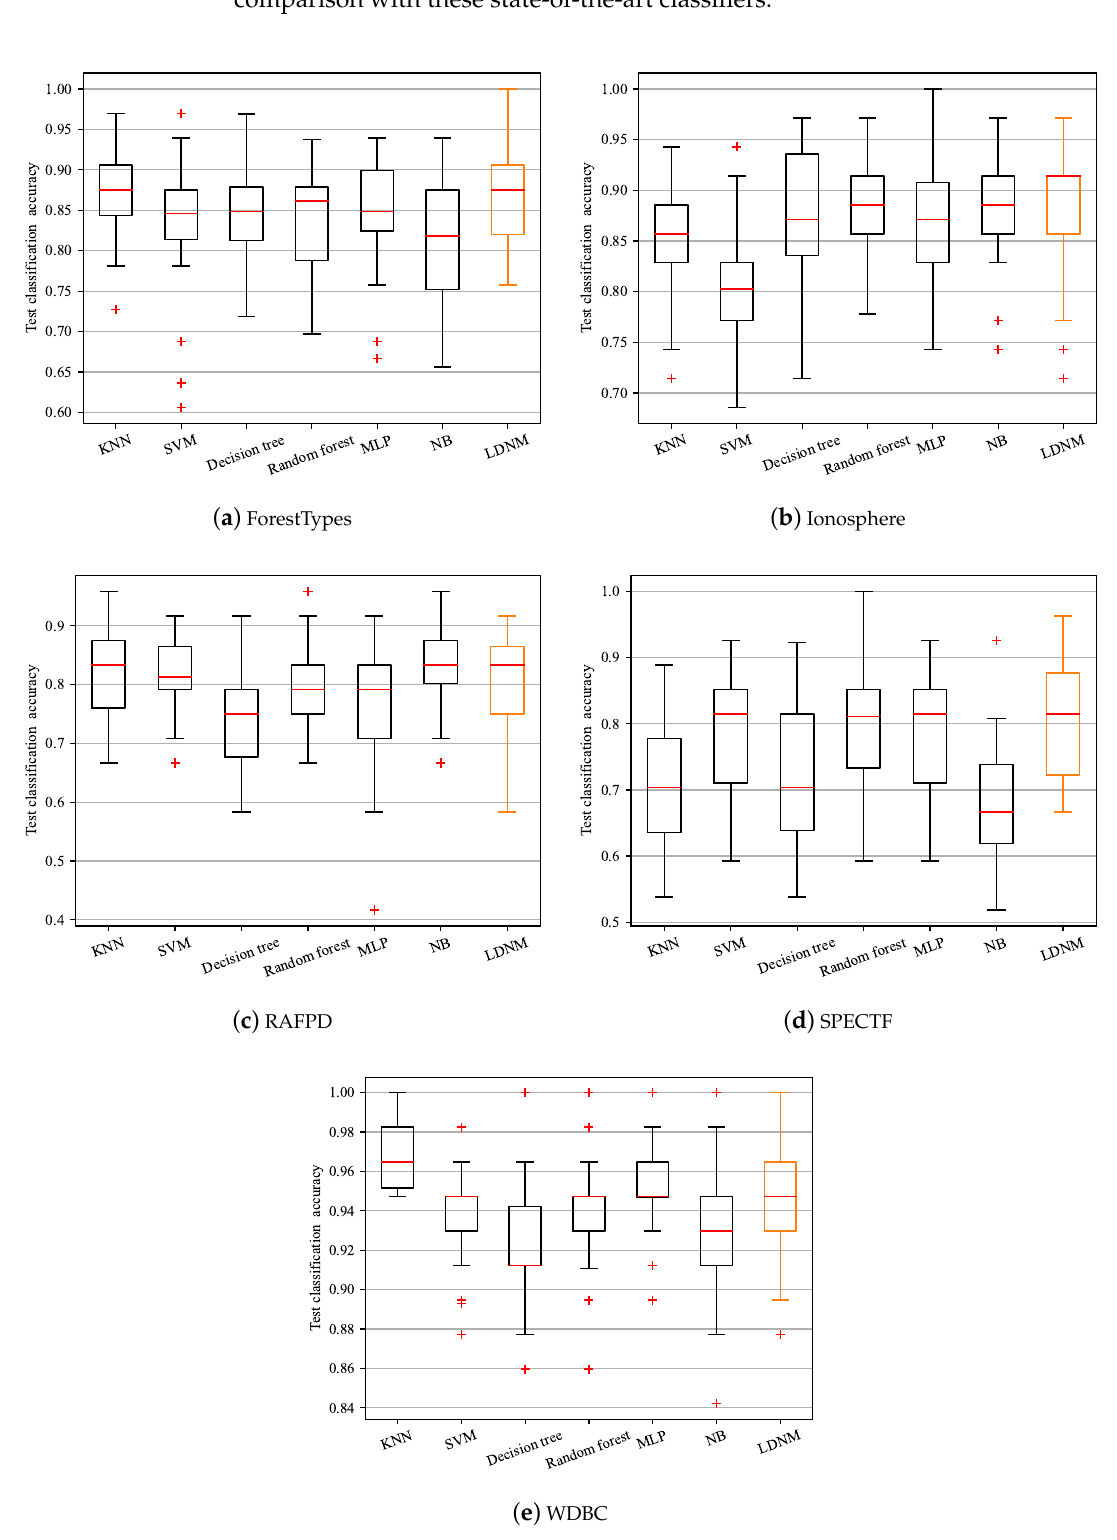
Figure 9. Box and whisker diagram of test classification accuracy for five benchmark